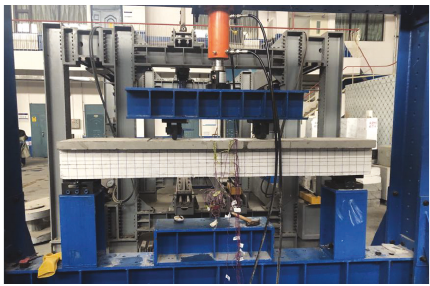
2 SO 4 solution configuration.